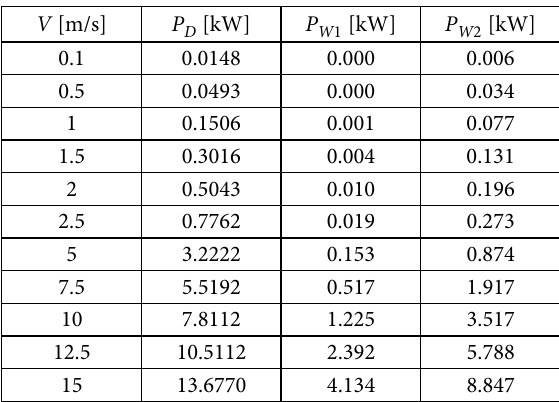
= 2.75·45 = 124 kJ. Z